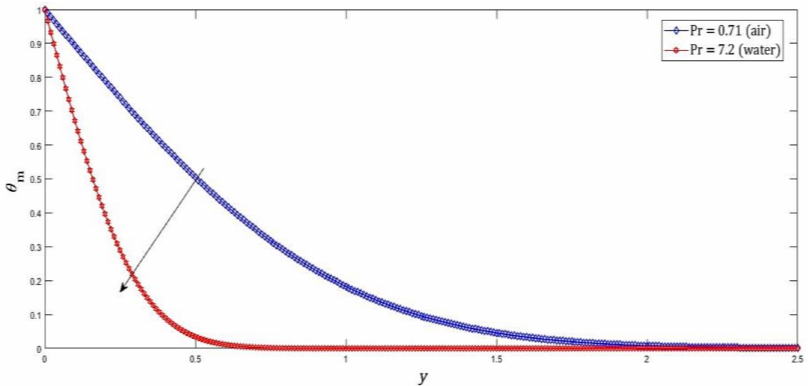
Figure 7. Variation in temperature profile with respect to Prandtl number.